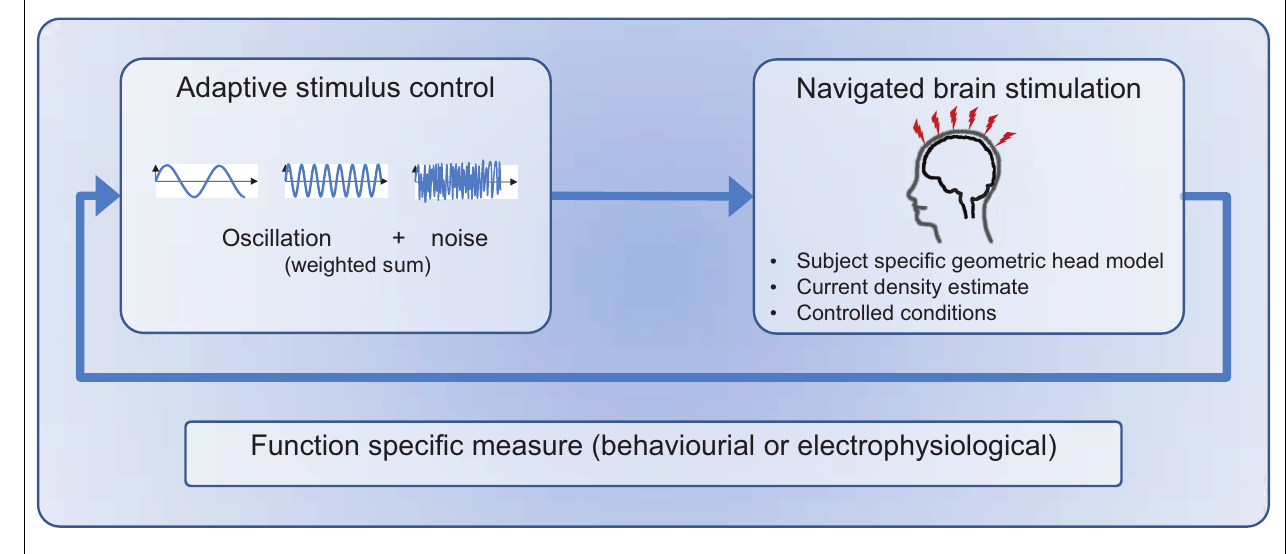
FIGURE 2 | In order to formulate a closed-loop approach for different stimulation paradigms, the following components are needed: (i) a set of stimulation parameters, common to all methods (e.g., stimulus strength